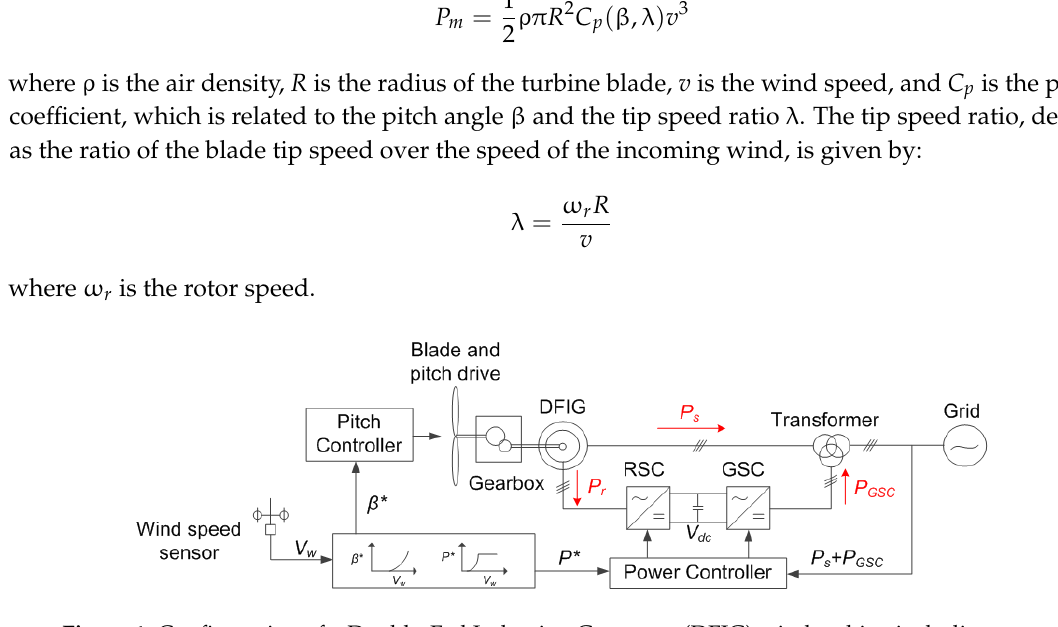
Figure 1. Configuration of a Doubly ‐ Fed Induction Generator (DFIG) wind turbine including power converter and controller. RSC, Rotor ‐ Side Converter; GSC, Grid ‐ Side Converter. converter and controller. RSC, Rotor-Side Converter; GSC, Grid-Side